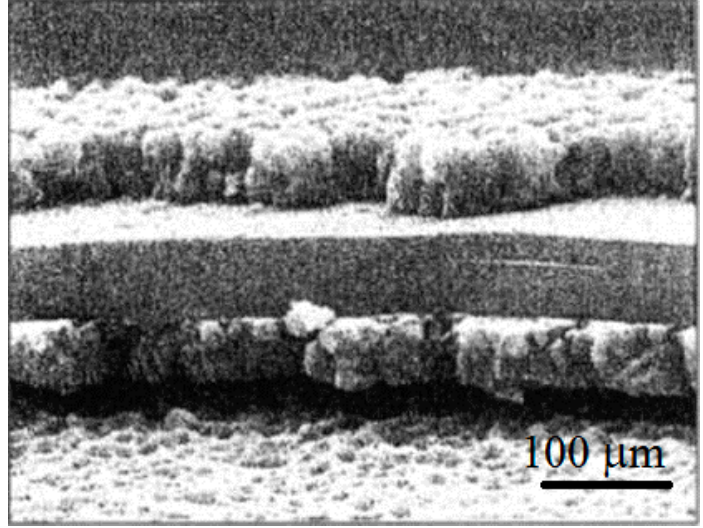
Figure 12. SEM image of the phlogopite flake coating of titanium dioxide.